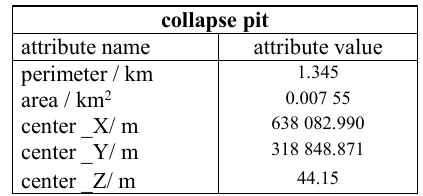
Table 1. Geometry information of subsidence